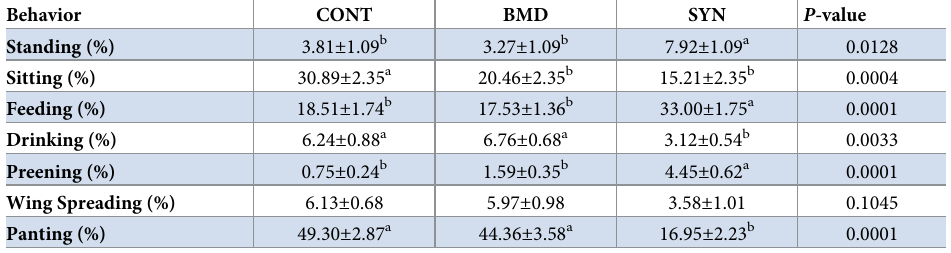
Table 3. Effect of dietary supplementation of synbiotic (SYN) and antibiotic (BMD) on behavioral patterns of broiler chickens reared under heat stress condition. Behavior